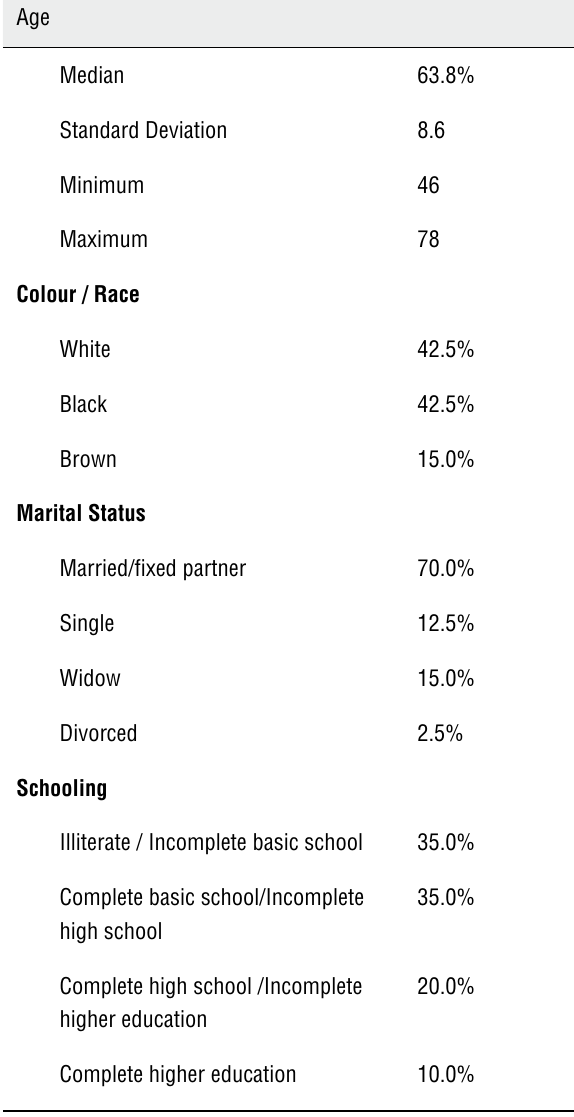
Table 1 - Socio-demographic